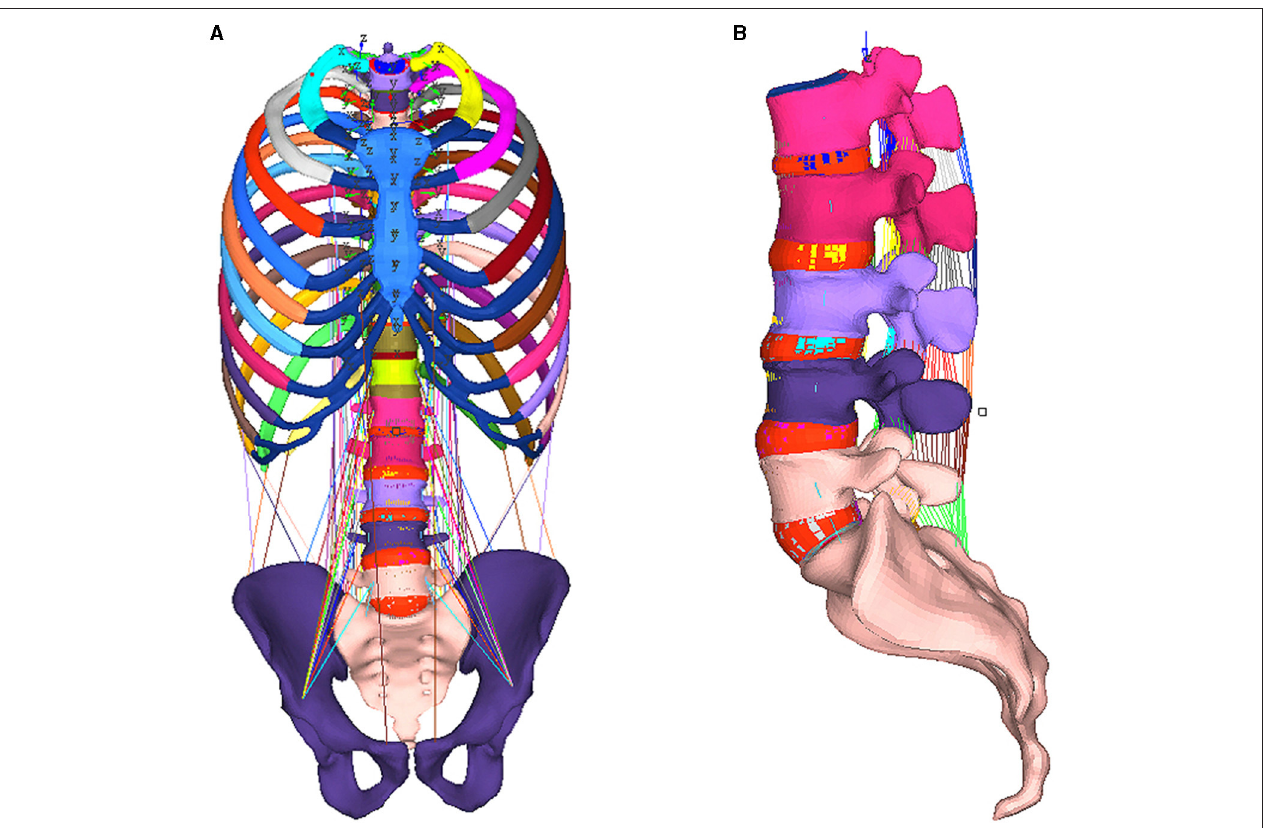
FIGURE 1 | Integral map of lumbar spine model (A) and the lumbar spine FE model [ (B) excluding